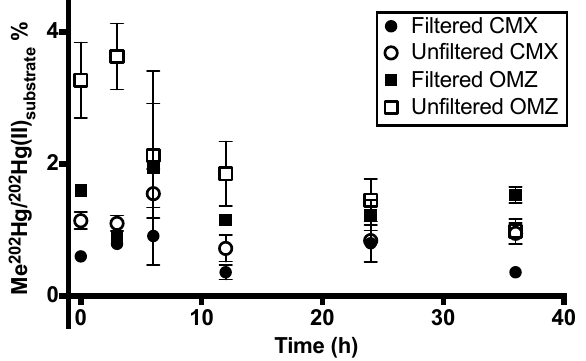
Figure 3. Pacific water column methylated mercury (MeHg) pro- duction over 36h at 12 ◦ S. Methylation rates from triplicate incuba- tion bottles ( ± 1 SD) in 0.2µm filtered and unfiltered water from the chlorophyll-maximum and oxygen-minimum depths in the South Pacific. Rapid demethylation of MeHg occurred in the presence of particles in unfiltered low-oxygen water. Newly produced MeHg only persisted beyond 12h in 0.2µm filtered